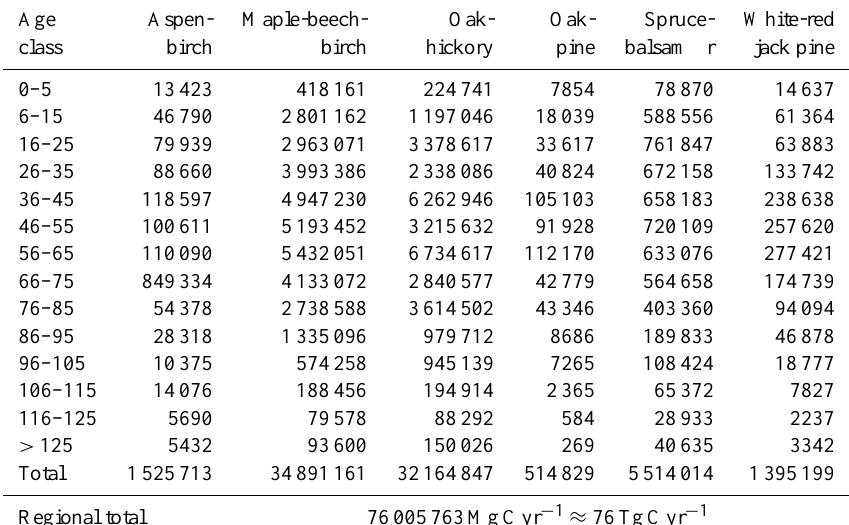
Table 3a. Area-weighted NEP (MgCyr − 1 ) by forest type for the Northeast US (based on the mean values of NEP (MgCha − 1 yr − 1 ) from afforestation sites.)